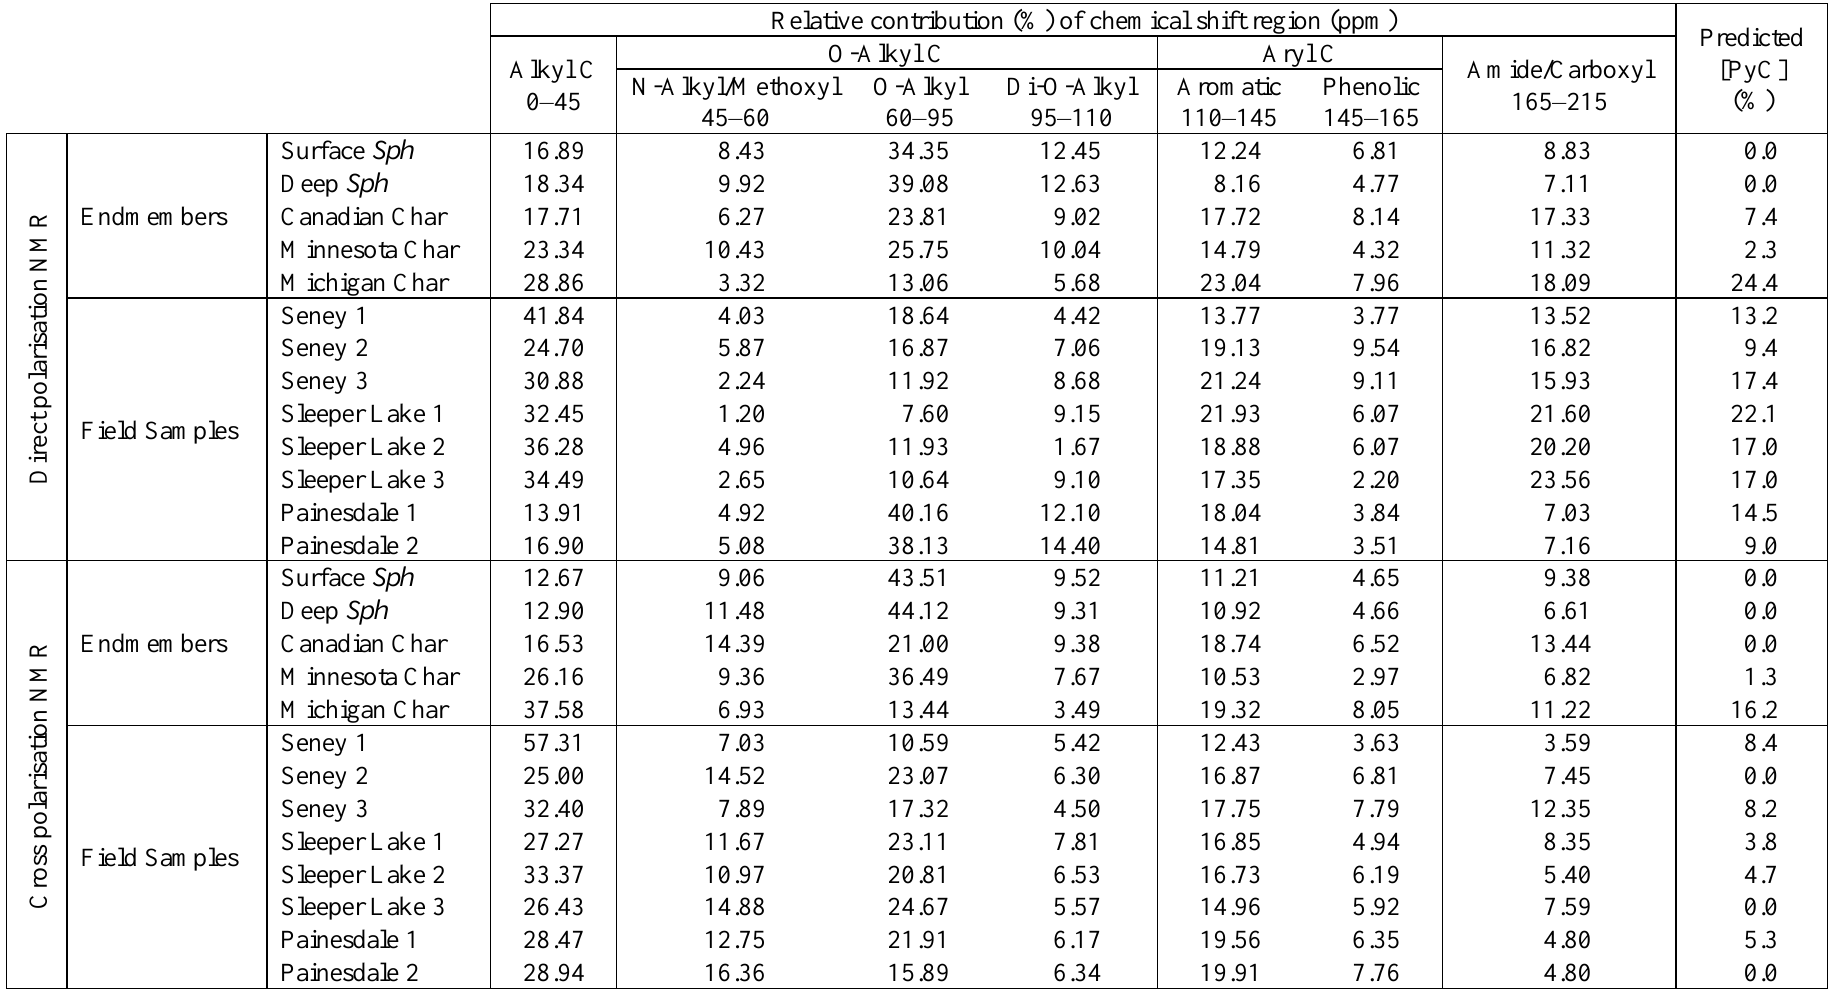
Table A2. Summary of NMR chemical shift regions and pyrogenic carbon concentration ([PyC]) predicted by the modified molecular mixing model (Baldock et al . 2004). Further data are available in Tables A3 and